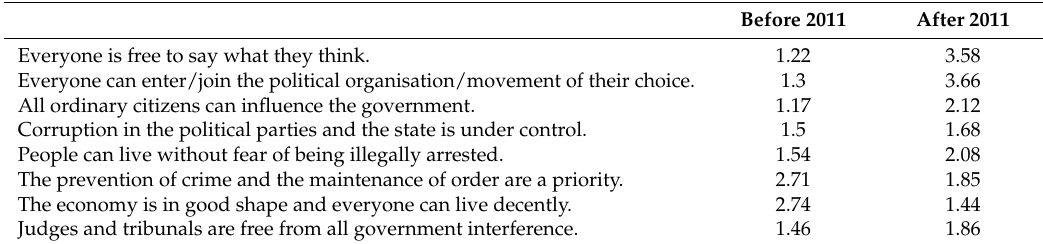
Table 6. Views on system of government before and after 2011 (mean